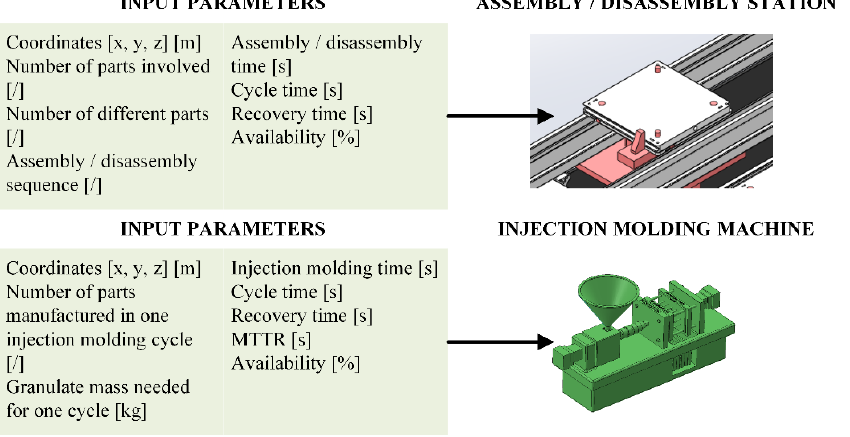
Figure 5. Two examples of “Fabrication” building blocks.